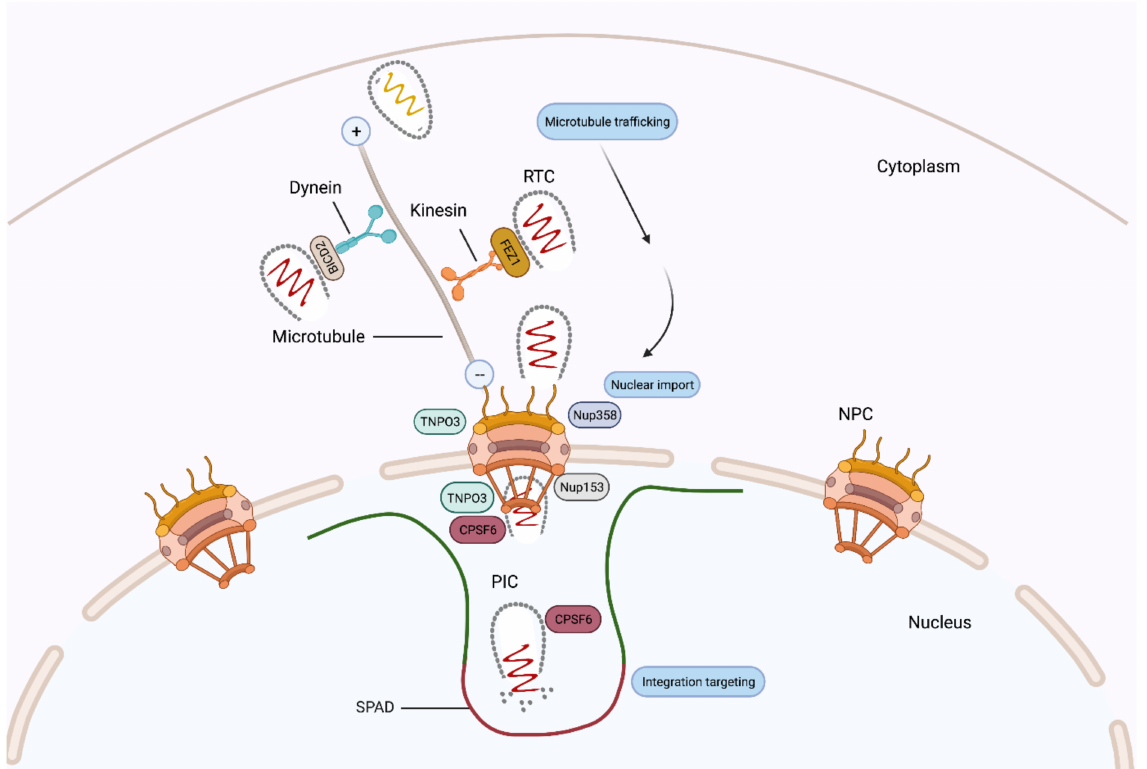
Figure 3. A model showing HIV-1 CA-interacting host factors during microtubule trafficking, nuclear import and integration targeting. Dynein adaptor protein BICD2 and kinesin-1 adaptor protein FEZ1 bind to HIV-1 CA and facilitate the HIV-1 reverse transcription complex (RTC)/pre-integration complex (PIC) trafficking towards the nuclear membrane. At the nuclear pore complex (NPC), Nup358 interacts with the CA protein and mediates the docking of RTC/PIC. Then, Nup153 interacts with the CA protein and mediates PIC translocation through the NPC. CPSF6 then binds to and directs CA to active regions of euchromatin, proximal to nuclear speckles and speckle-associated domains (SPADs). TNPO3 also facilitate virus integration, possibly by promoting nuclear core